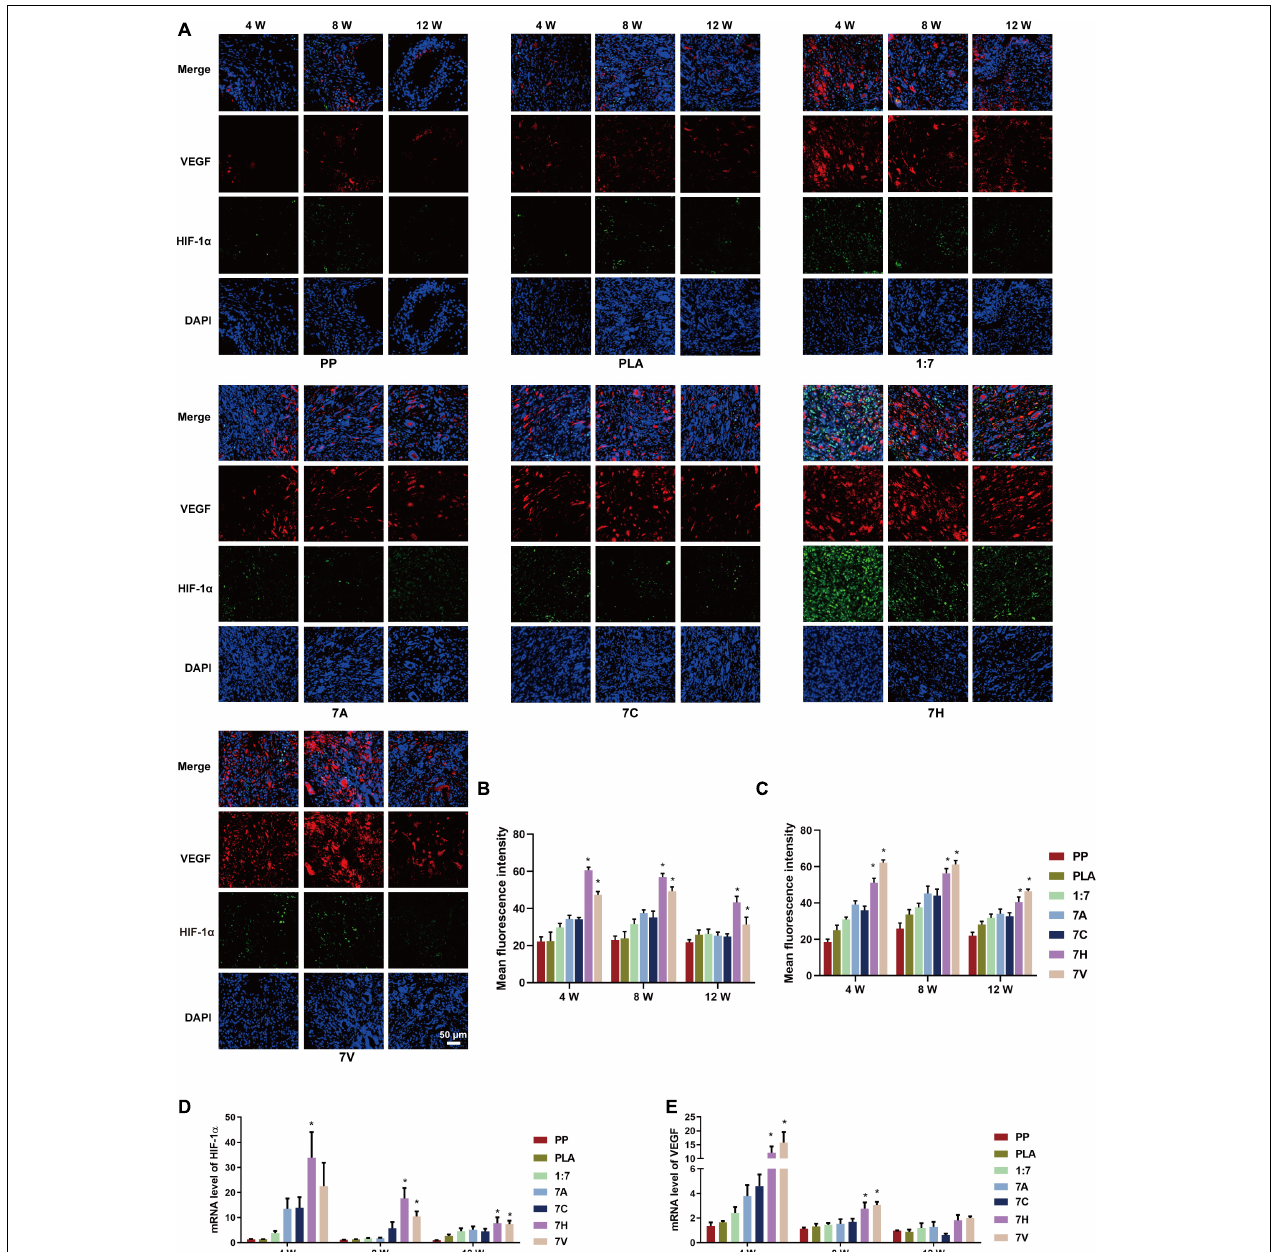
FIGURE 7 | Expression of HIF-1 α /VEGF in regenerative tissue of abdominal wall defect model. (A) Expression of HIF-1 α and VEGF in regenerative tissue detected by immunofluorescent staining (green: HIF-1 α , red: VEGF, blue: DAPI) (Scale bar = 50 µ m). (B) Mean fluorescence intensity of HIF-1 α . (C) Mean fluorescence intensity of VEGF. (D,E) mRNA levels of HIF-1 α and VEGF in regenerative tissue detected by RT-PCR testing. * P < 0.05 vs. the PP, PLA, 1:7, 7A, and 7C